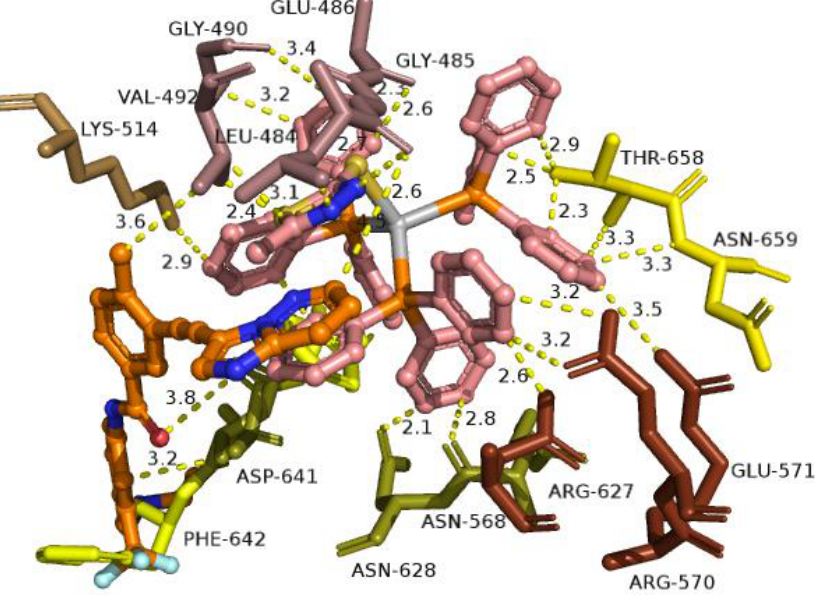
Figure 10. A close-up view of the binding site mapping architecture of the best binding pose of complex 2 in the crystal structure of FGFR1 target protein. Complex 2 is illustrated to be anchored at the ATP-binding cleft of the protein at the same place as the co-crystallized inhibitor ponatinib. Docked complex 2 as well as the superimposed ponatinib are rendered in ball-and-stick mode and colored according to atom type in salmon and orange C atoms, respectively. Selected contacting residues of the binding pocket are colored according to the FGFR1 protein’s segments shown in Figure 9. Binding contacts are shown as yellow dotted lines. Heteroatom color-code: O: red, N: blue, S: yellow, P: orange, and Ag: gray. Hydrogen atoms are omitted from all molecules for clarity. The final structure was ray-traced and illustrated with the aid of PyMol Molecular Graphics Systems.